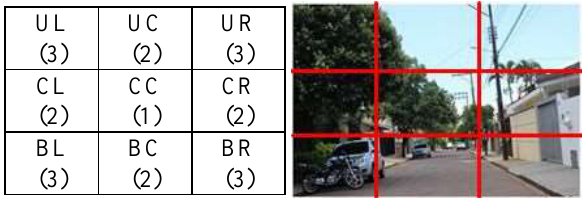
Figure 3 – Image plane sectors: U for upper, C for center, B for bottom, L for left, and R for